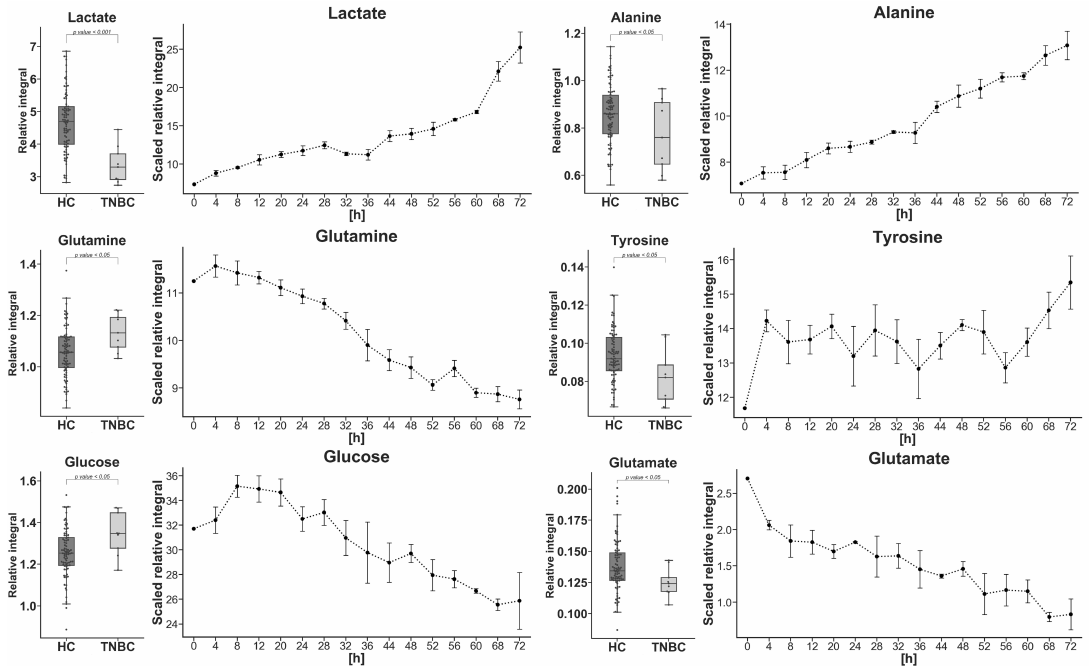
Figure 2. Statistically important metabolites identified from the HC vs. TNBC (box plots) comparison with matching scaled relative integral from MDA-MB-468 medium extracts. Data points in the line plots were calculated based on the mean values of triplicates for each time interval with standard deviation error bars. In the boxplot: whiskers = 1.5 × IQR, lines = average; boxes = interquartile range